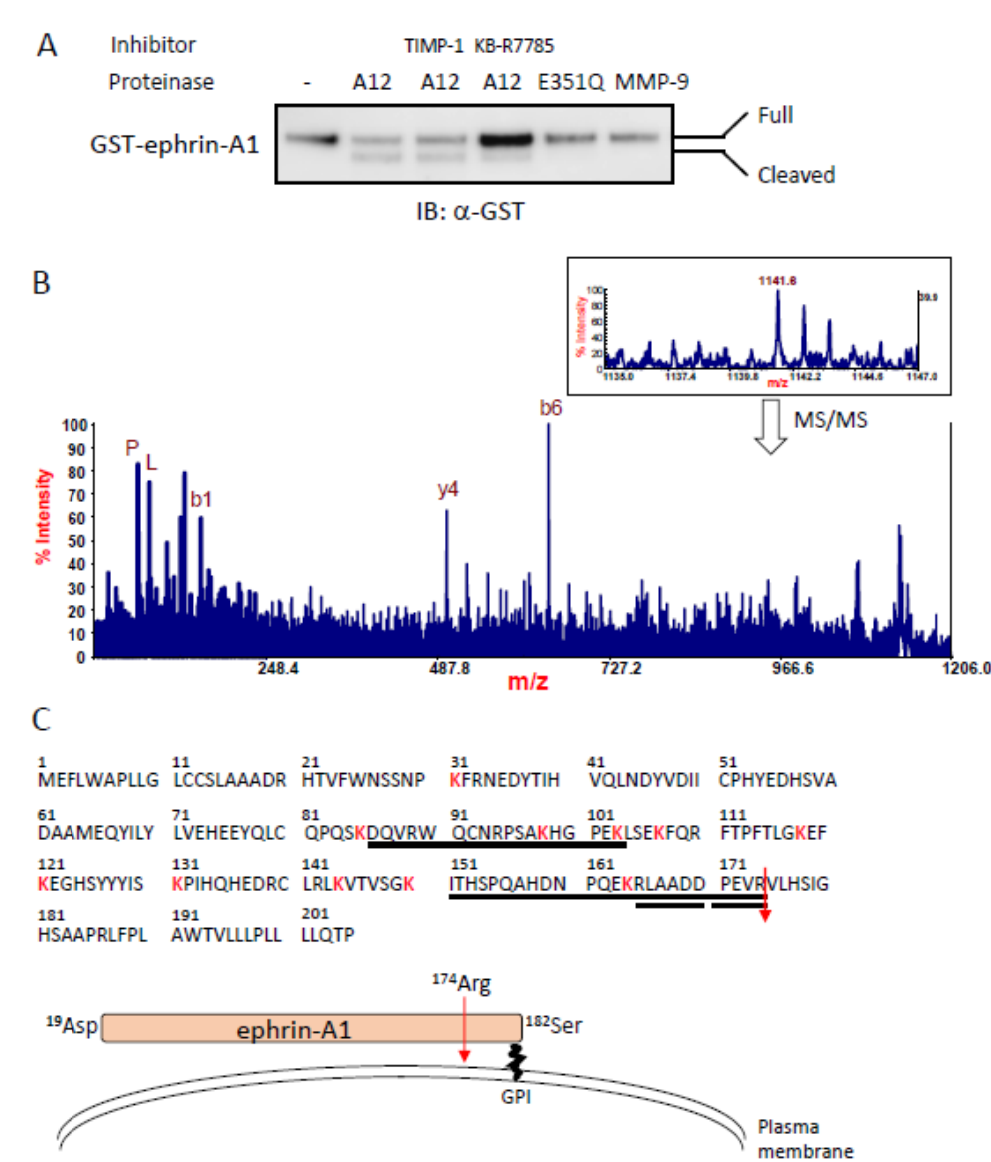
Figure 1. Mass spectrometric analysis of ADAM12-cleaved ephrin-A1. ( A ) ADAM12-mediated cleavage of ephrin-A1. GST-ephrin-A1 was incubated with recombinant human ADAM12-S. GST- ephrin-A1 was cleaved by ADAM12. KB-R7785 inhibited ADAM12-mediated ephrin-A1 cleavage but not TIMP-1, an MMP-9 inhibitor. ( B ) MALDI-MS (inset) and MS/MS spectra of the C-terminal LEP peptide of ephrin-A1. The protein was digested with LEP in buffer prepared with H 218 O (see Materials and Methods). The digested peptides, but for the C-terminal one, were labeled at the C termini with 18 O, which allowed for identification of the C terminal peptide of the protein as a non-labeled one. The ion peak at m/z 1141.6, which was observed as a non-labeled peak, could correspond to the peptide, R 165 LAADDPEVR 174 (calcd. 1141.6, MH + ). It was further confirmed by MS/MS, giving several sequence ions (b6: RLAADD, y4: PEVR, etc.) specific for the peptide [25] . Single characters (P, L) denote the immonium ions derived from the peptides. ( C ) Analysis of the C-terminal peptide of ephrin-A1 by MALDI-MS/MS. Cleaved ephrin-A1 was digested with LEP in buffer prepared with 18 O-labeled water. The LEP peptide (R 165 LAADDPEVR 174 ) was identified and observed as a non-labeled peptide by MALDI-MS/MS. The results indicate that ephrin-A1 was cleaved immediate after Arg at position 174 in ephrin-A1 amino acid sequence.